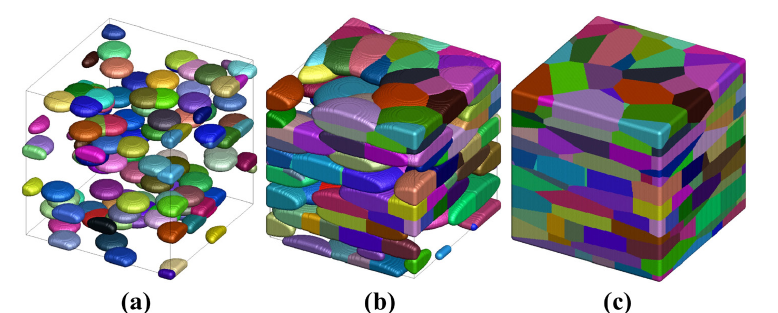
Figure 1. Microstructure of oblate ellipsoids nucleated on 20 random parallel planes with 20 random nuclei on each plane. The nucleation was site-saturated. That is, all nuclei started to grow at the time origin: t 0 = . The ratio of the length of the longer axes to the length shorter axis of the ellipsoid is 4:4:1. Each figure depicts the microstructure corresponding to a progressively higher fraction transformed, V V : a)